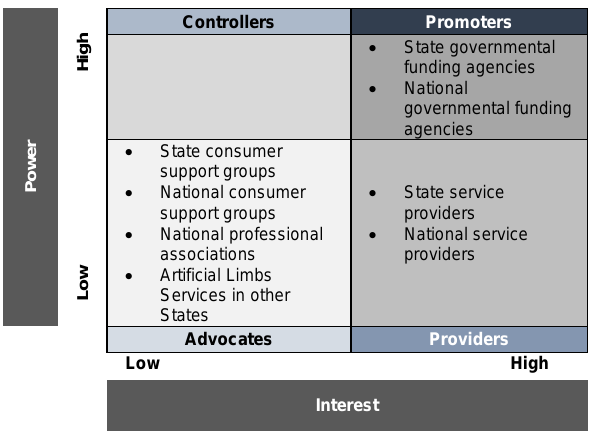
Figure 8: Typical stakeholder matrix including groups of controllers, promoters, providers and advocates of the procedure depending on power (e.g., capacity to influence allocation of resources) and interest (e.g., capacity to provide prosthetic and medical care). Adapted from Frossard et al (2018) .17 Future studies could confirm whether the delivery of BAP changes the scope of practice (e.g., skills, risks) and business models (e.g., effects on incomes) for all allied health professionals (e.g., prosthetists, physiotherapists, occupational therapists). The outcomes of this preliminary CUAs could assist in building plausible scenarios